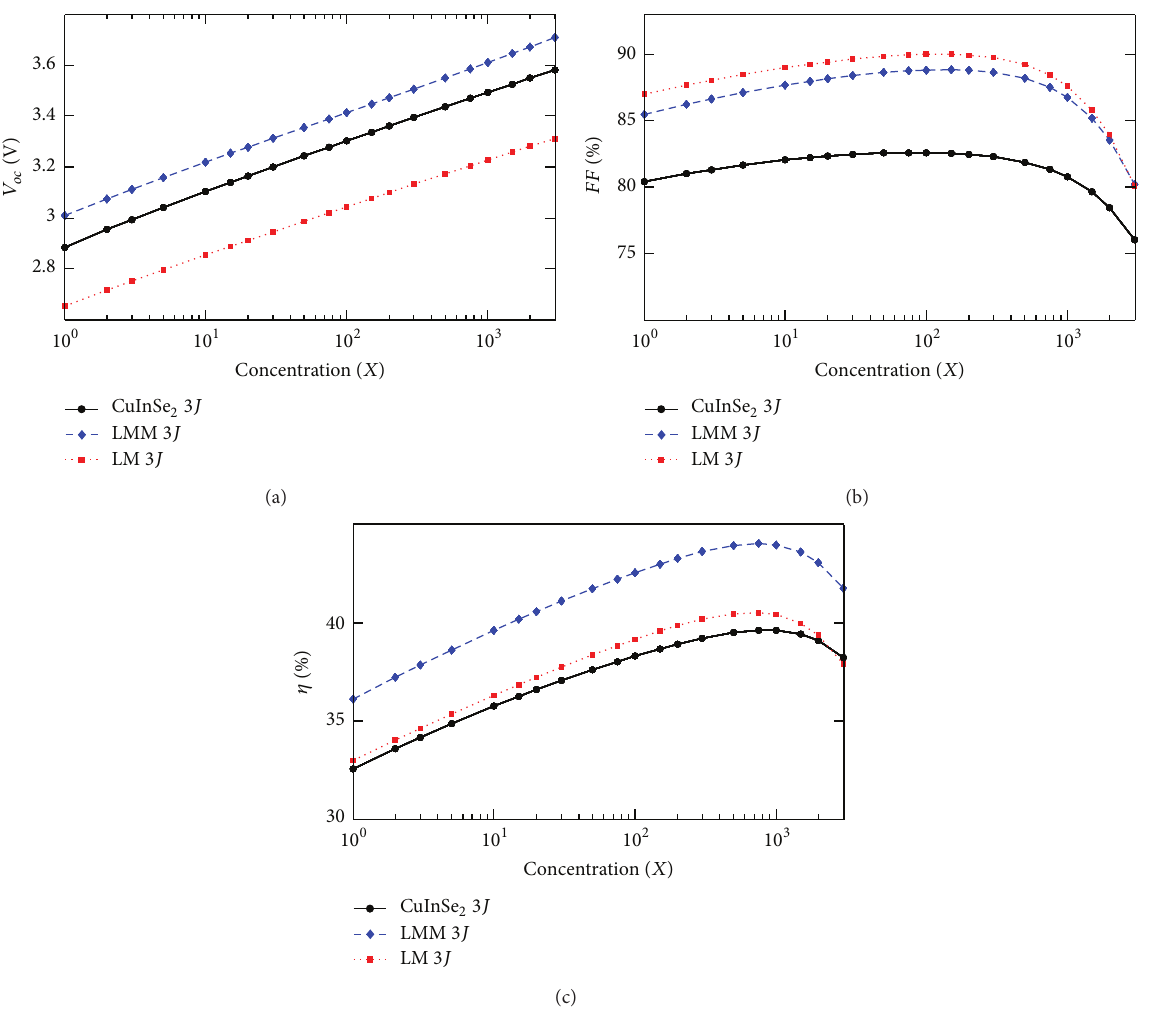
Figure 8: Simulated (a) 𝑉 , (b) FF, and (c) efficiency of the CuInSe 2 3J at 300 K as a function of the concentrated illumination ratio (𝑋) for oc = 10 5 cm −2 and surface recombination velocities of 10 3 cm/s. The simulated data is compared to the predicted performance of the TDD bot LMM 3J with the same TDD and to the LM